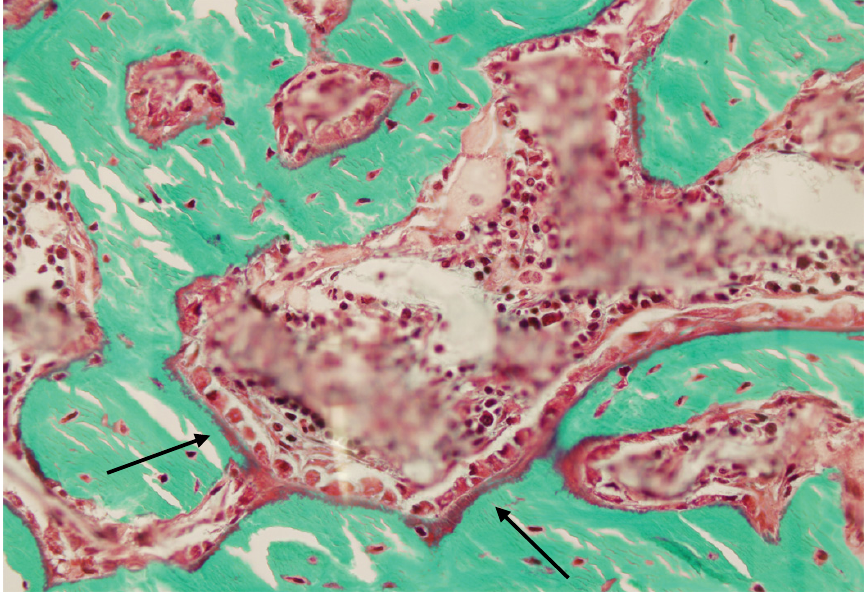
Figure 5. High magnification view of left operated femur a bone marrow-ablated (bmx) rat treated five days per week with PTH for 28 days. Note the presence of active osteoblasts lining the new bone (arrows).